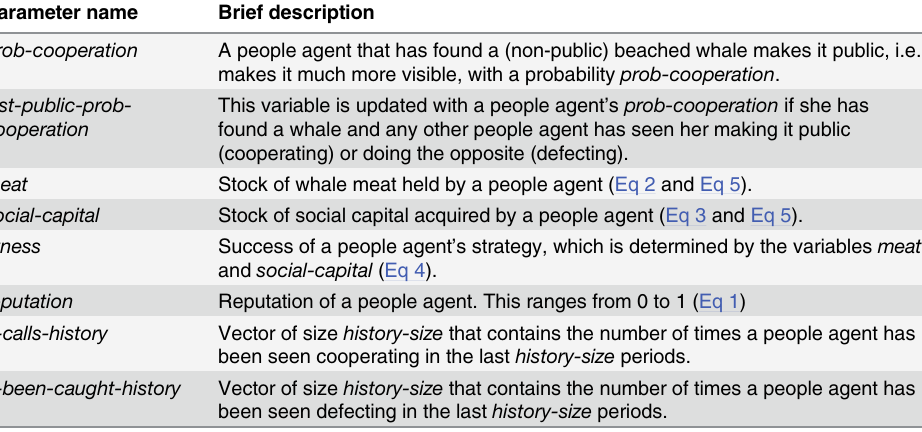
Table 2. People state